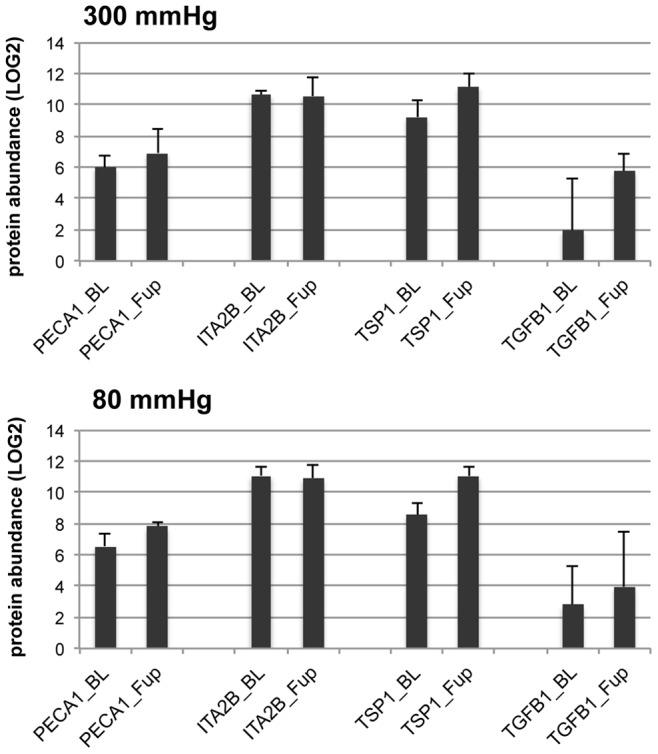
Label-free quantification of individual proteins.Bars represent mean abundance values (LOG2 values of normalized PMSS) of individual proteins before (BL) or after (Fup) ECP therapy with 300 mmHg (top) or 80 mmHg inflation pressure (bottom). Whiskers represent one standard deviation. Proteins displayed are PECA1 (CD31), ITA2B (CD41), TSP1 (thrombospondin-1), and TGFB1 (transforming growth factor beta-1).